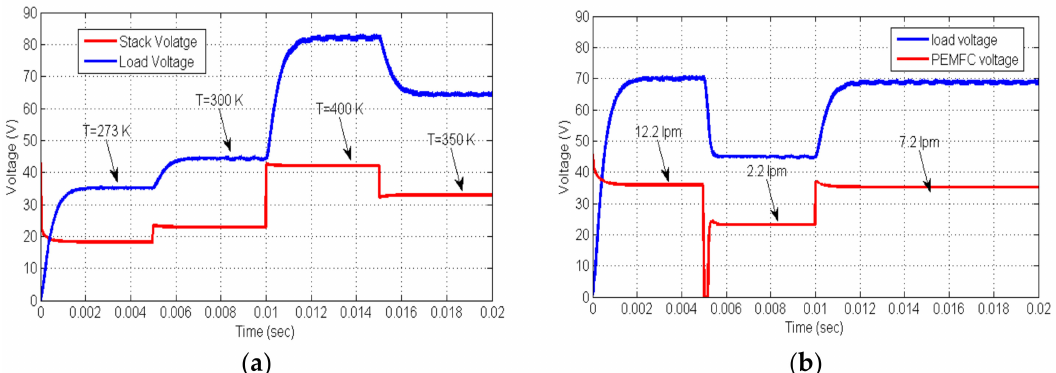
Figure 6. PEMFC and load voltages for ( a ) temperature variation ( b ) variation of fuel flow rate.